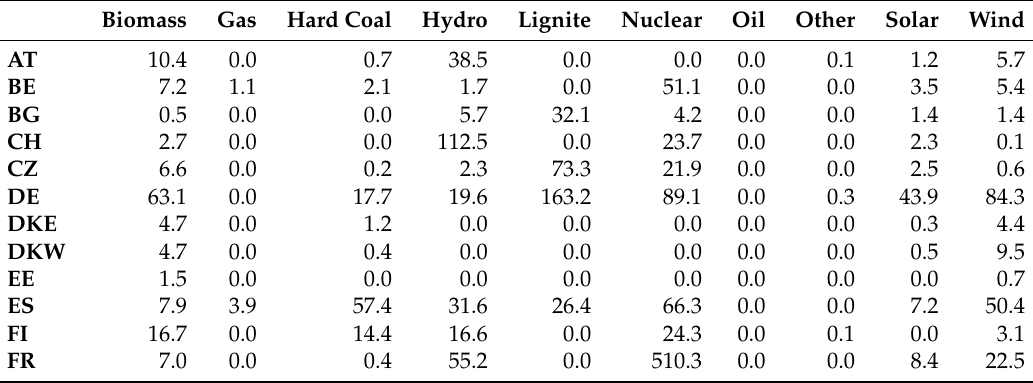
Table A2. Electricity generation